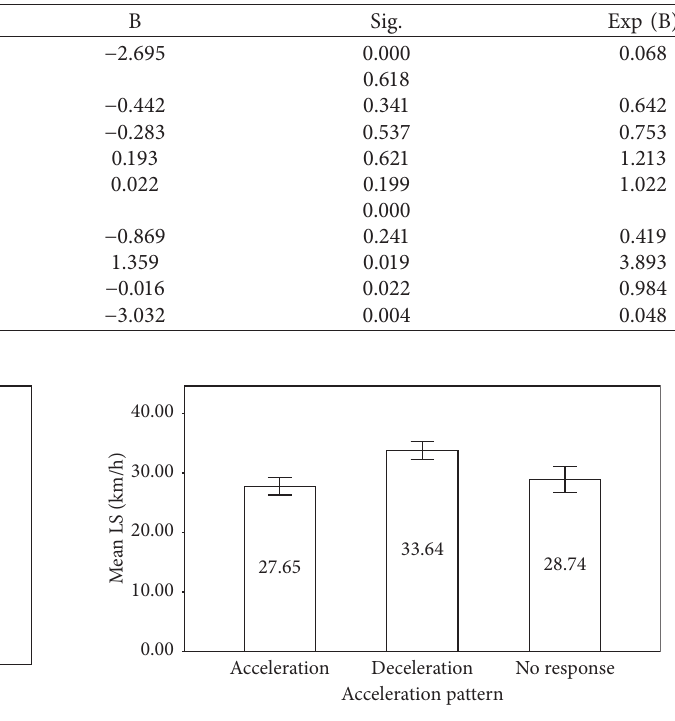
Figure 10: Fitted mean profiles of AA with respect to acceleration pattern.